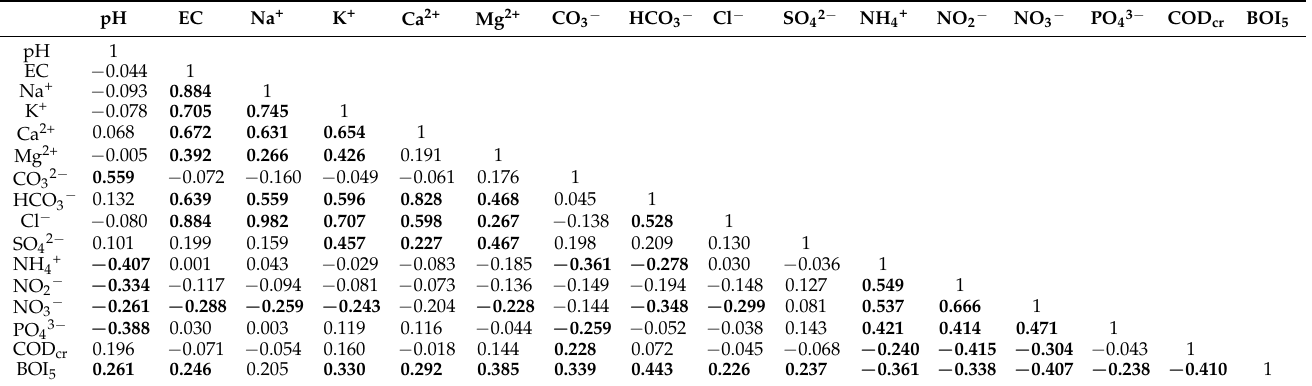
Table 4. Spearman correlation coefficients for the investigated hydrochemical parameters.